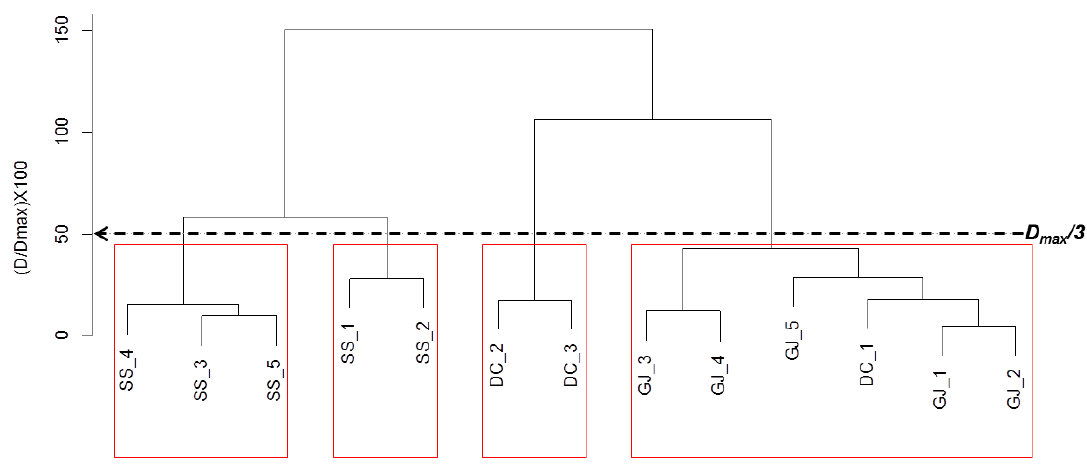
Figure 11. Dendrogram of monitoring sites during rainy days (D: Distance, Dmax: Maximum Distance).